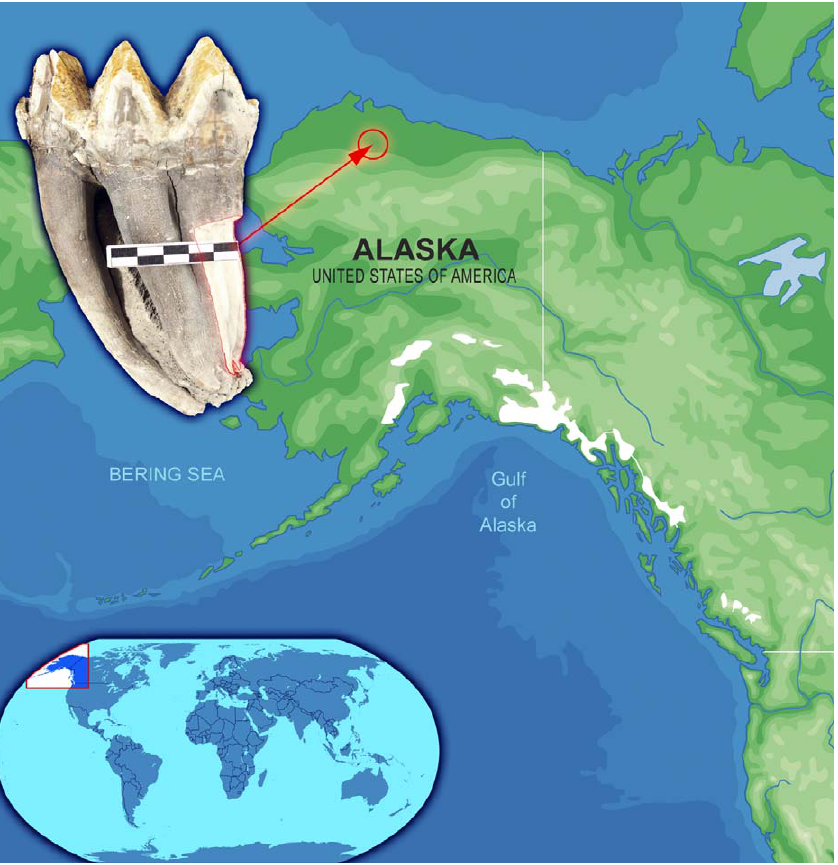
Figure 1. Appearance and Location of Origin of the Mastodon Tooth (IK-99–237) Used for Sequencing of the mtDNA Genome The scale bar shows centimeters.